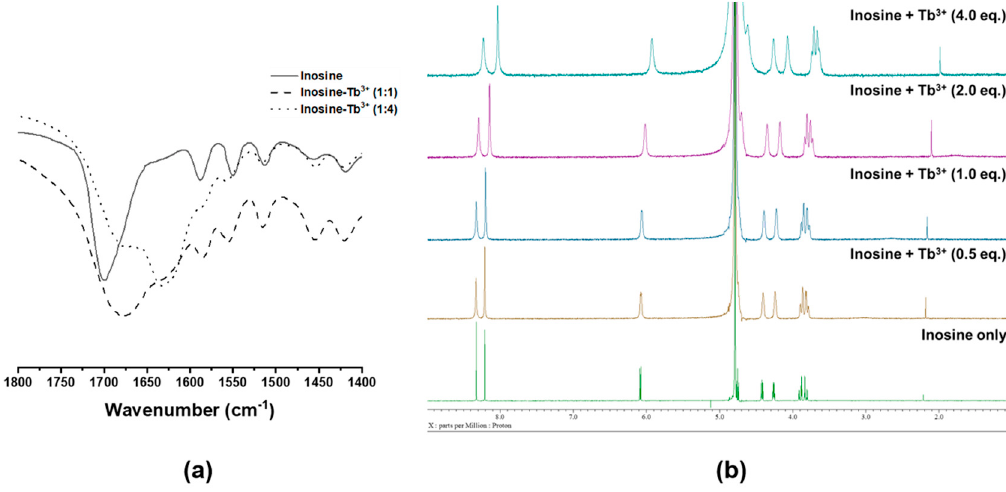
Figure 3. ( a ) IR spectra in the 1400–1800 cm − 1 region of inosine in absence and presence of Tb 3 + . ( b ) 1 H NMR profile of inosine free (5 mM) and with different Tb 3+ equivalents.